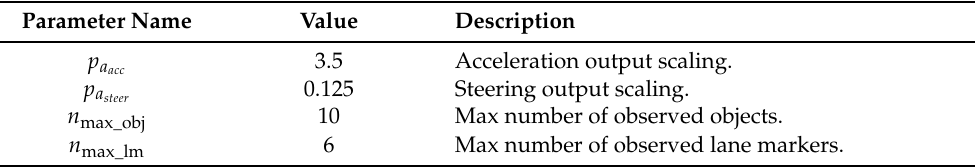
Table A2. Values of parameters related to direct control network and its inputs/outputs.